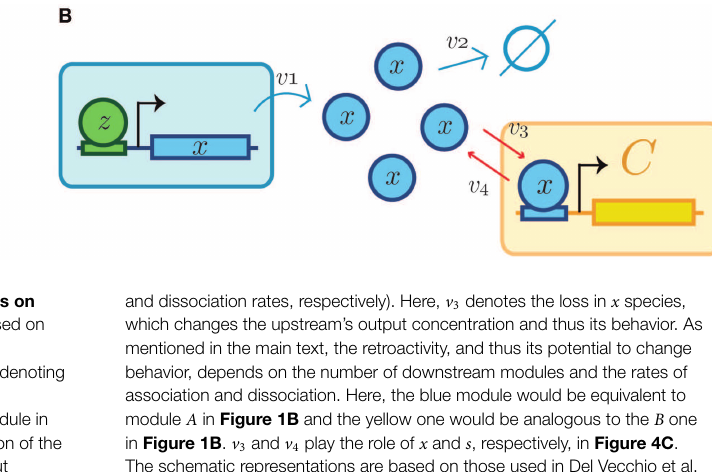
FIGURE 6 | Retroactivity changes the system’s behavior (focus on retroactivity to the output) . (A) Isolated input–output module (based on Figure 1A ). This is a cartoon representation of the system, with the processes involved in the module output in blue arrows and with v 1 denoting the rate of production of x (output signal) due to the presence of a transcription factor z . v 2 denotes the degradation of x . Here, the module in blue would be equivalent to A in Figure 1 . (B) Cartoon representation of the connected system, with the involved processes in the module output denoted by blue arrows and connection processes represented by red arrows as a set of binding/unbinding events (with v 3 and v 4 the association